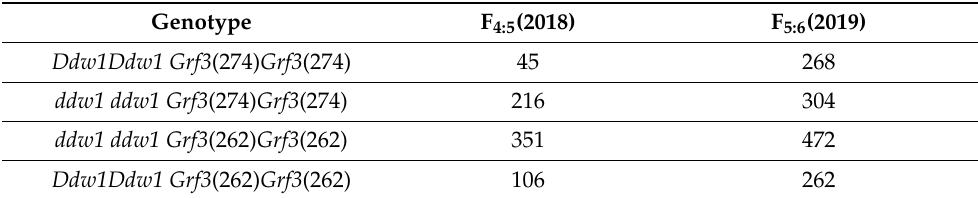
Table 2. Numbers of analyzed F 4:5 (2018) and F 5:6 (2019) plant samples by genotype.